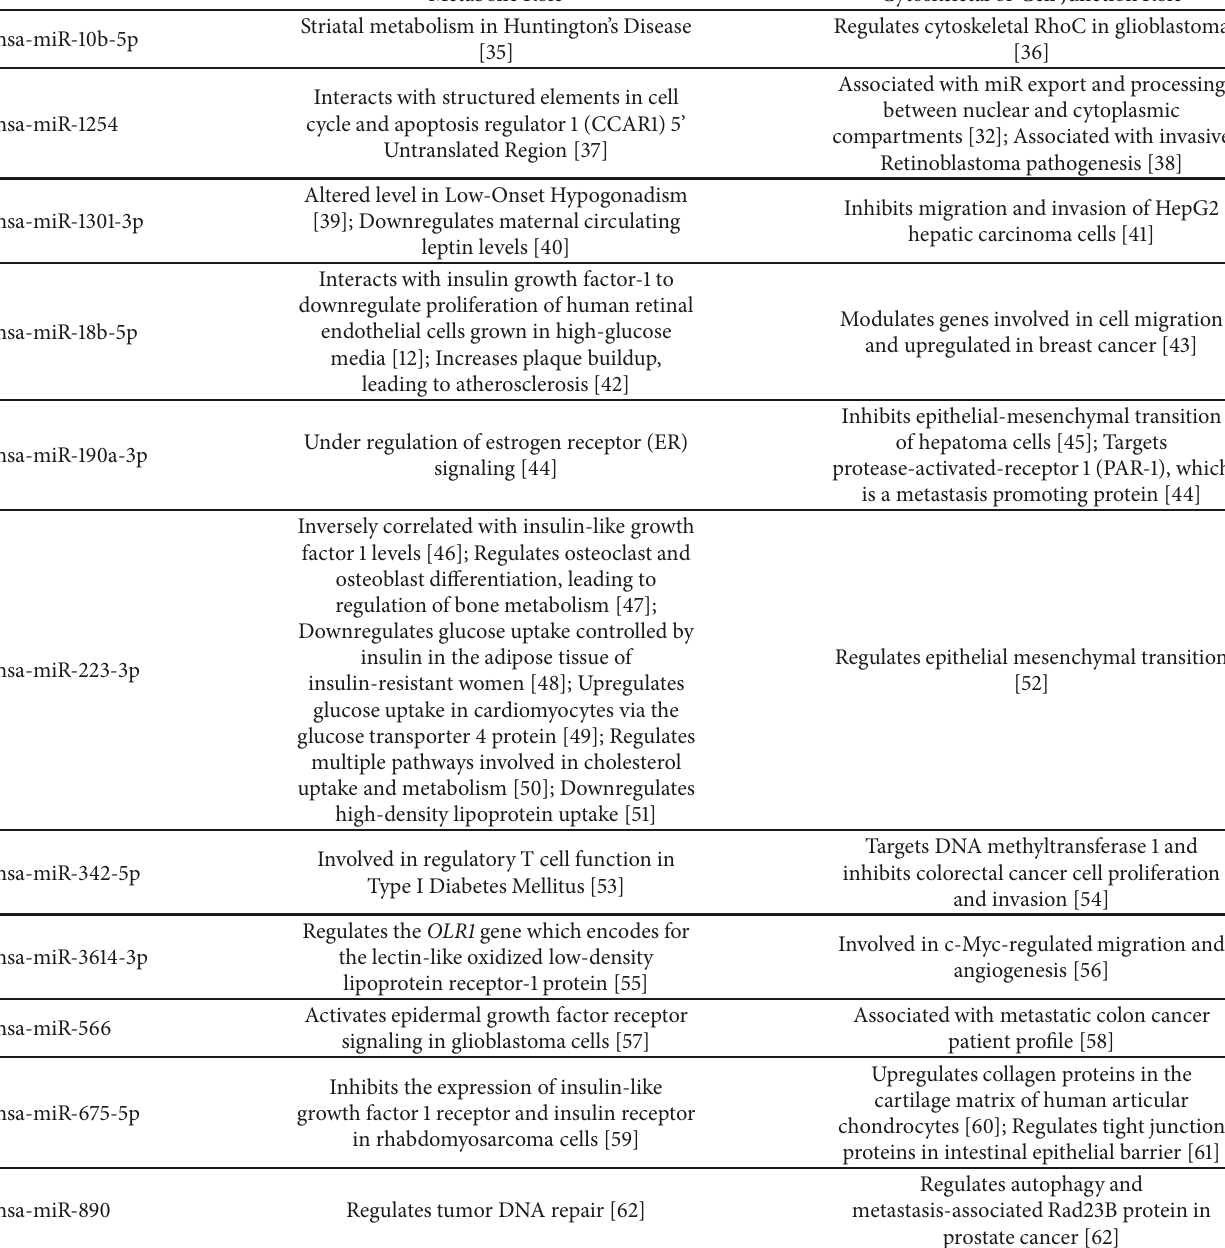
Table 2: Metabolic and cytoskeletal signaling roles of eleven common miR targets of the MetS-FL miR